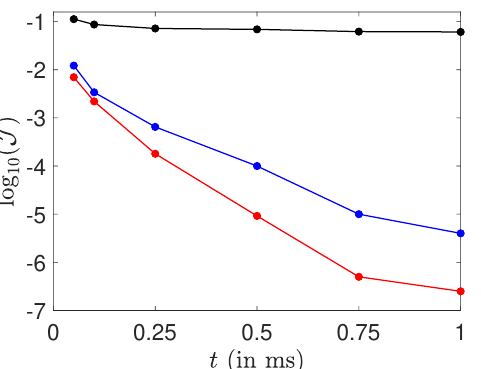
Figure 5. Evolution of the logarithm of the cost functional J as a function of the control time for different maximum amplitudes (black, 30 V·m − 1 ; blue or dark gray, 50 V·m − 1 ; red or light gray, 70 V·m − 1